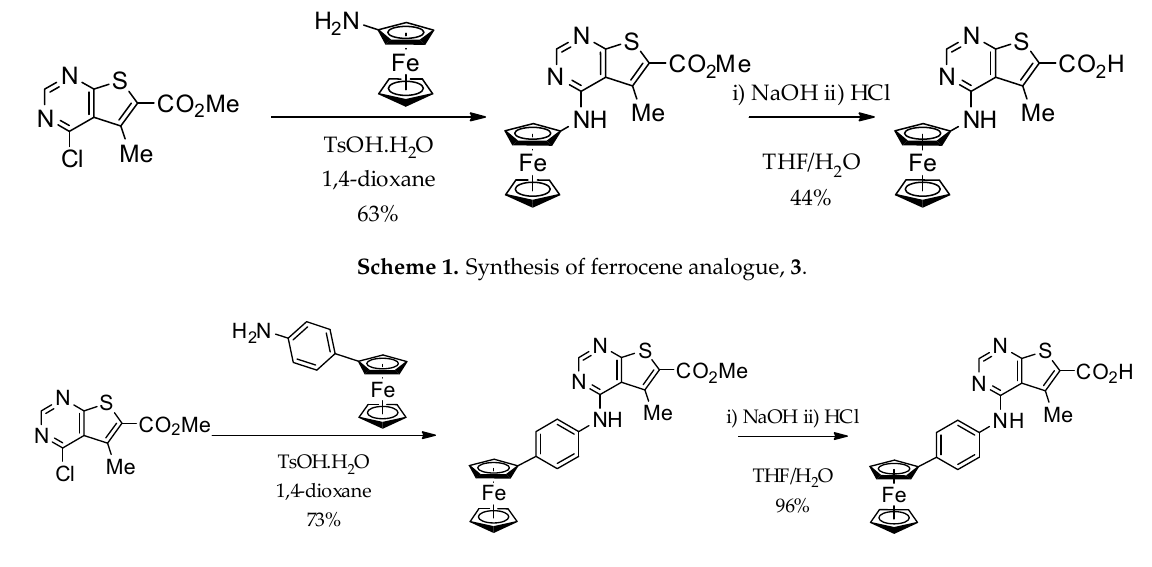
Scheme 2. Synthesis of ferrocene analogue, 5 .